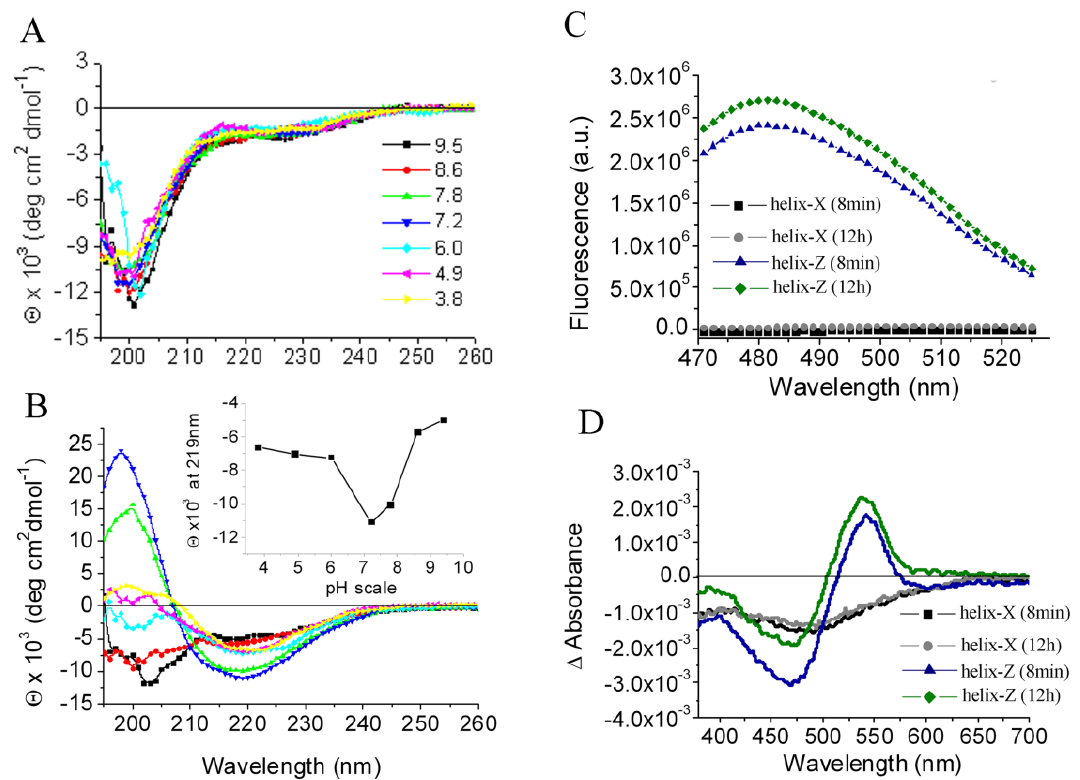
Figure 2. Circular dichroism (CD) spectra of helix- X ( A ) and helix- Z ( B ) in a pH range of 3.8–9.5. Inset in ( B ) shows ellipticity values at 219 nm; ( C ) Fluorescence assay coupled to ThT, showing a characteristic peak at 482 nm; ( D ) Birefringence changes of Congo red (Δ absorbance) at different incubation times. The peptide concentration used in all CD assays was 200 µg/mL, for ThT assays was 50 µg/mL, and for Congo red assays 180